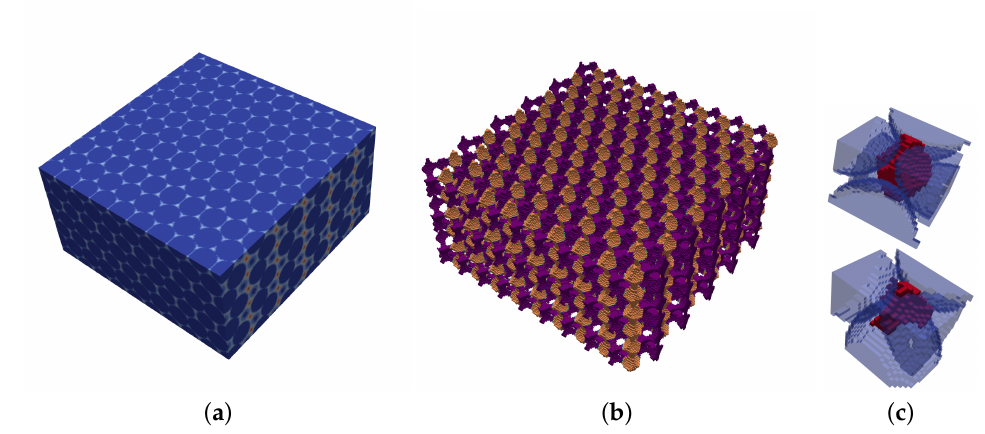
Figure 8. Local void detection in a close hexagonal packing. ( a ) EDT representation; ( b ) segmented pore space; ( c ) characteristic local